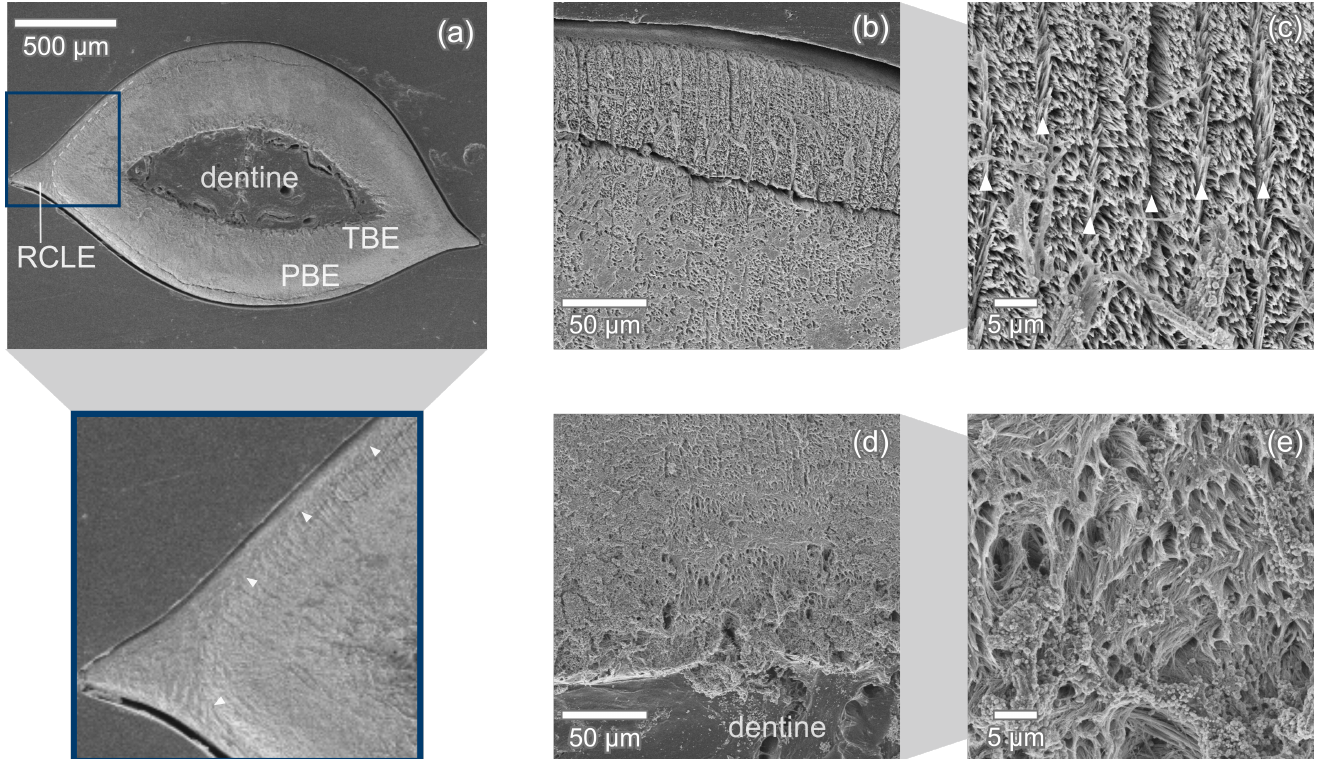
Figure 7. Transversal section of C. taurus tooth. ( a ) The enameloid cover is made up of an outer enameloid (RCLE) clearly separated (dashed line, arrow heads in zoomed-in view) from the inner enameloid which itself consists of TBE and PBE. ( b , c ) In the middle of the tooth edge, the outer enameloid appears to be worn away and parallel aligned crystal bundles (PBE) intersected by evenly spaced thin radial elements (arrow heads) are visible. ( d , e ) In the inner enameloid close to the dentine, the bundles are interwoven and change orientation frequently in all directions. The crack apparent in ( a , b ) likely occurred during specimen preparation.